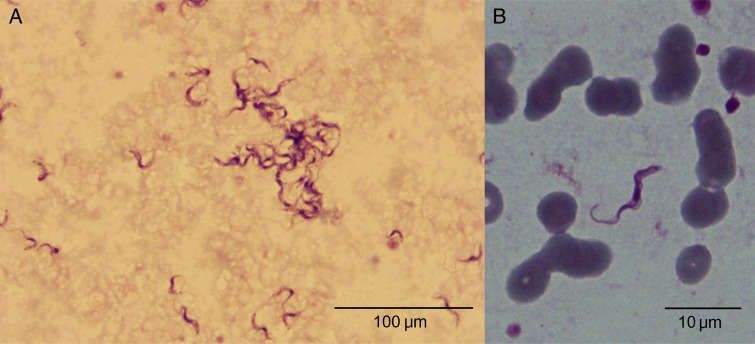
Giemsa-stained blood sample showing Trypanosoma evansi in the blood of a 38-year-old Vietnamese woman at ×100 (A) and ×1000 (B) magnification, with typical forms of the subgenus Trypanozoon parasites (total length 20–30 µm, free flagellum, central nucleus, large undulating membrane, subterminal small kinetoplastids [<0.8 µm], and a sharp posterior extremity).